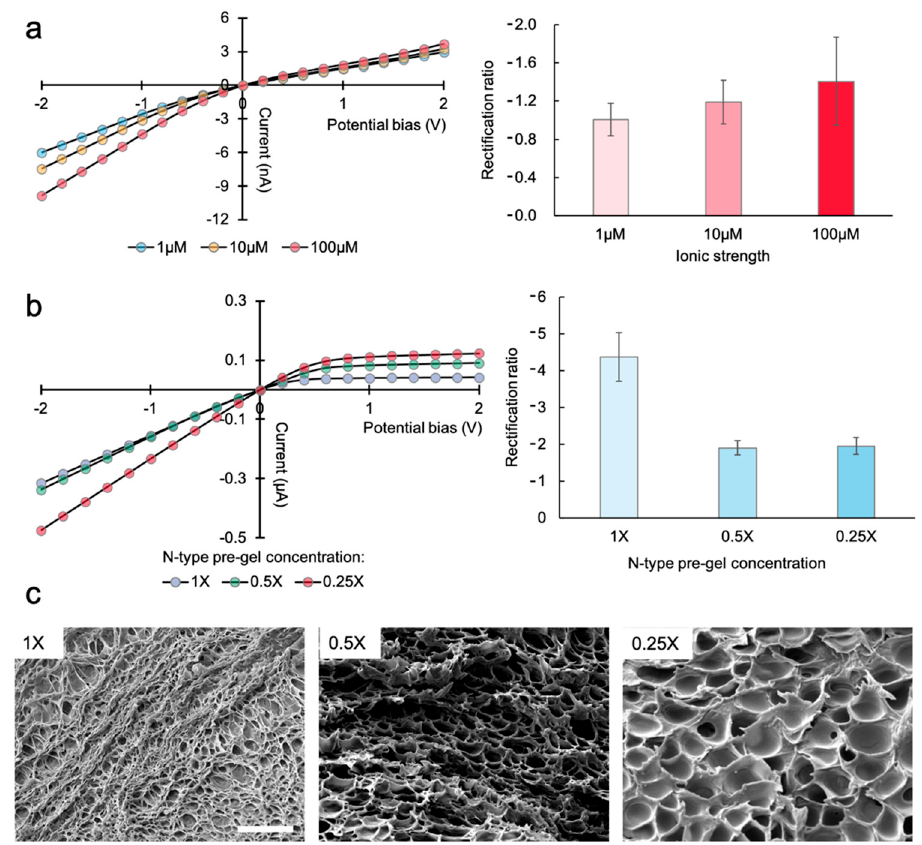
Figure 2. Characterization of the representative PHID device: ( a ) I-V curves (left) and rectification levels (right, n = 3) of a representative device obtained at various ionic strengths; ( b ) I-V curves (left) and rectification levels (right, n = 3) obtained at different N-type gel concentrations. The electrolyte solution is kept to 10 mM KCl and P-type gel concentration is kept to 1X; ( c ) SEM images of dried N-type gel blocks at different concentrations. Scale bar, 1 μ m.